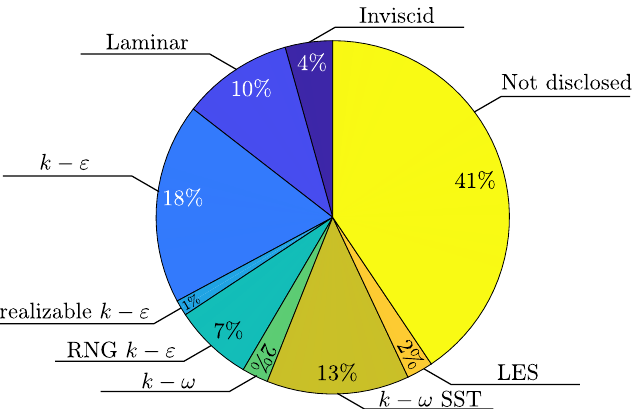
Figure 2. Flow conditions and turbulence models used for CFD-based NWT WEC applications and their relative share in the reviewed literature in